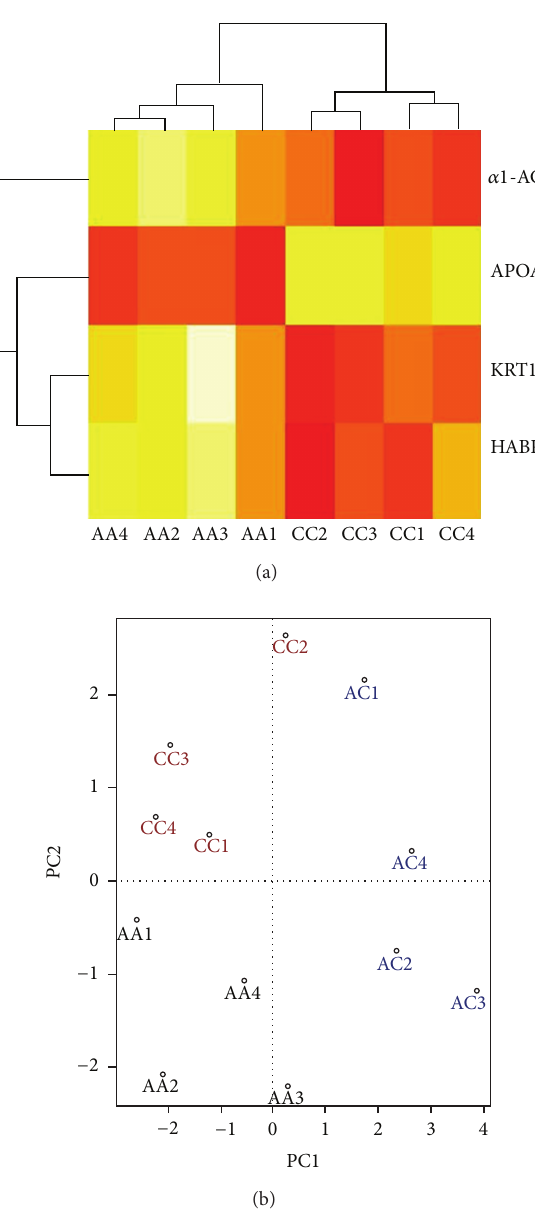
Figure 2: Global relationships were visualized by performing “hierarchical cluster analysis” (HCA (a)) and “principal component analysis” (PCA, (b)) according to the significantly changed proteins. AA1-AA4 and CC1-CC4 represent the eight samples for proteomics